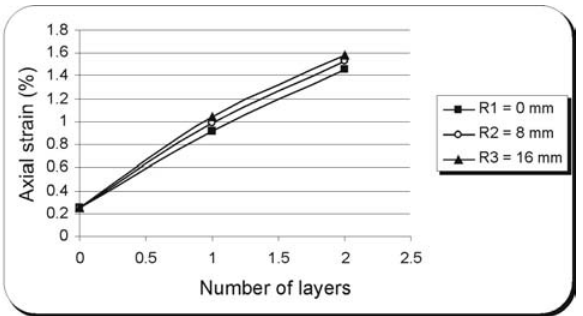
Fig. 5. Axial strains ( ε cc ) versus number of layers